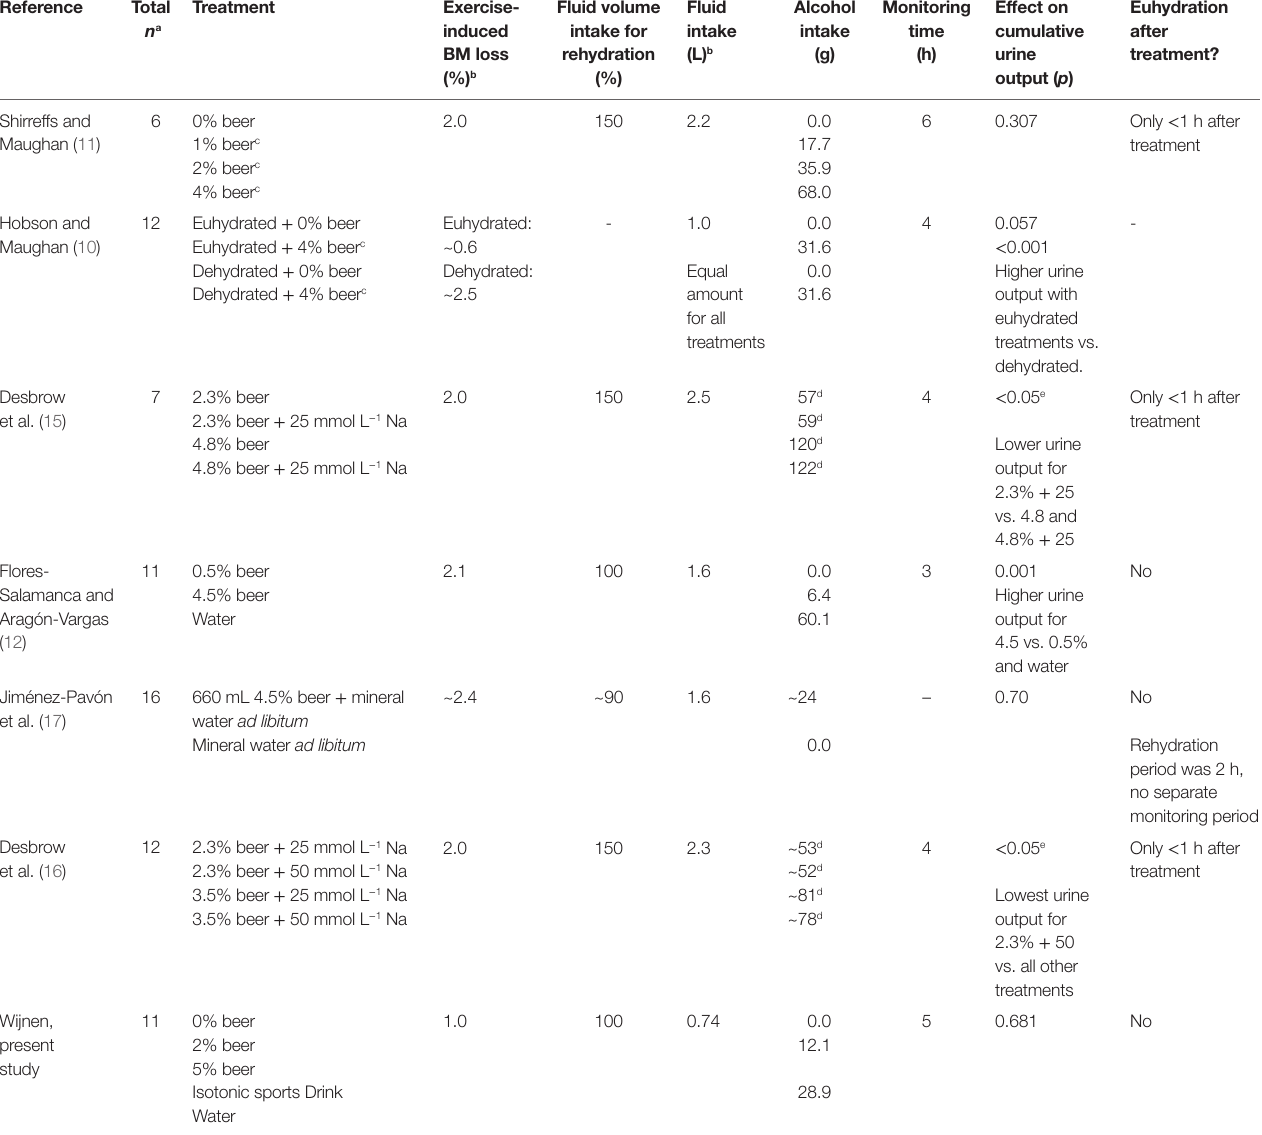
TaBle 5 | summary of randomized controlled crossover